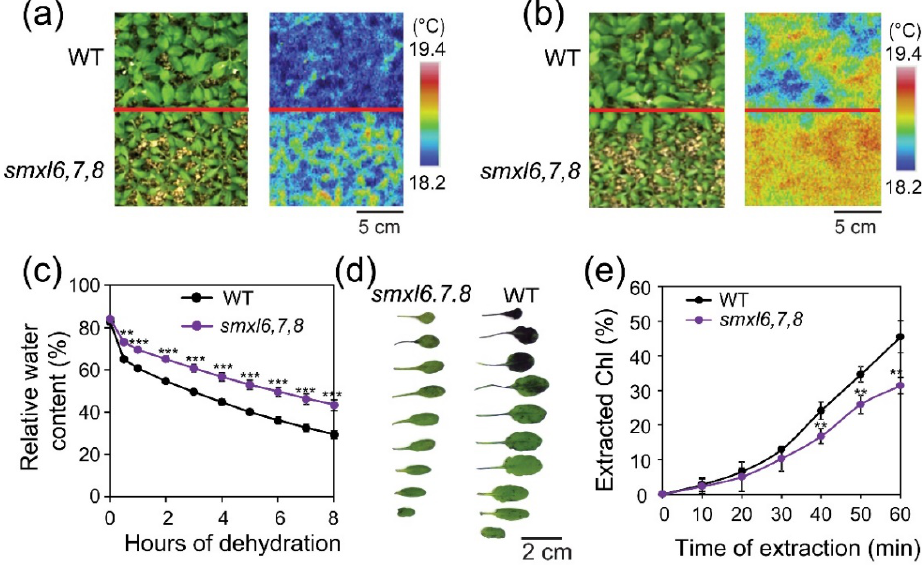
Figure 3. Leaf surface temperatures and cuticular permeability of smxl6 , 7 , 8 mutant and wild-type (WT) plants. ( a , b ) Leaf surface temperatures of the two genotypes without ( a ) and with soil-drying for seven days ( b ). ( c ) Relative water contents of rosette leaves of the two genotypes under dehydration. ( d ) Detection of cuticular permeability by toluidine blue staining of rosette leaves of four-week-old WT and smxl6 , 7 , 8 mutant plants grown under normal growth conditions. ( e ) Percentages of chlorophyll (Chl) leaching from the rosette leaves of four-week-old WT and smxl6 , 7 , 8 mutant plants grown under normal growth conditions. Data shown in ( c ) and ( e ) are means and SEs ( n = 5 plants). Asterisks show significant di ff erences between the two genotypes at each time point (Student’s t -test; ** p < 0.01 and *** p < 0.001).